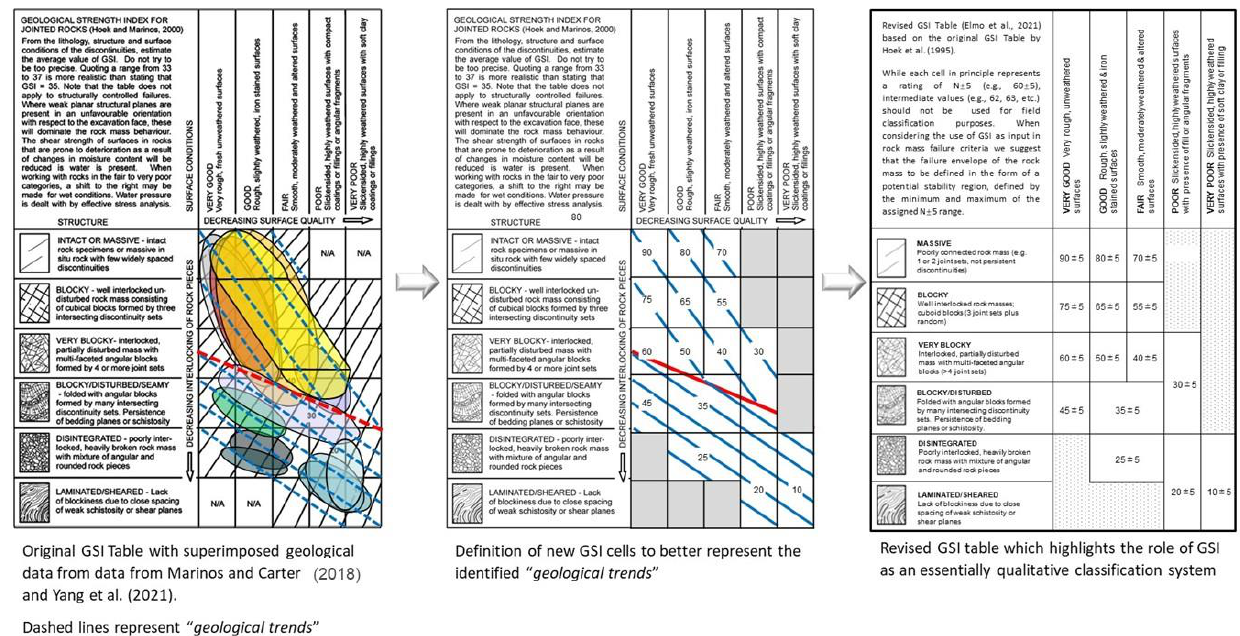
Figure 8. Proposed qualitative revision of the GSI table (1997)[21] to better account for geology and the irreversibility bias (modified from [2,61]).